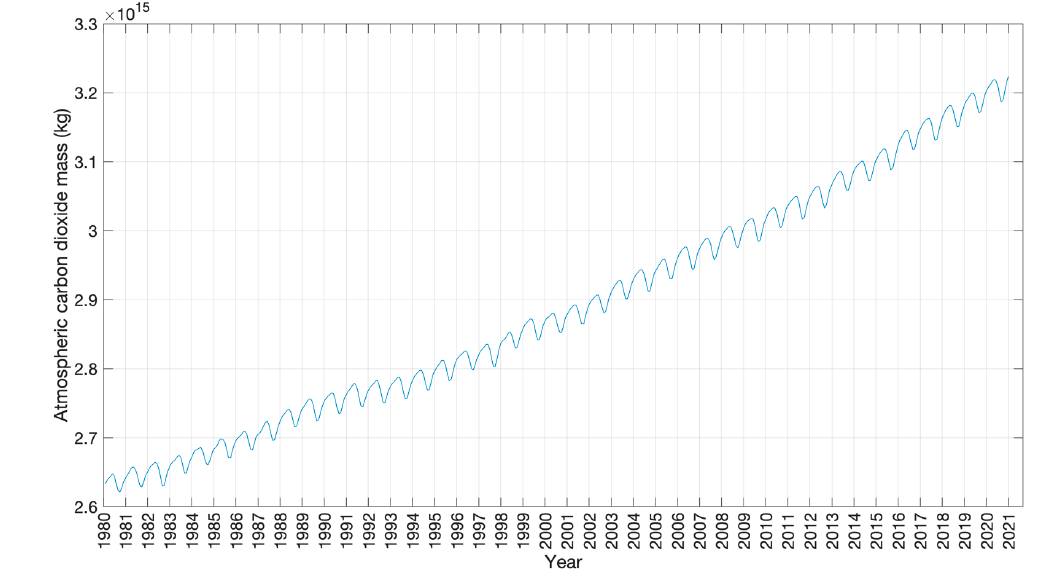
Figure A4. Global atmospheric carbon dioxide mass 1980–2021. Table A1. Stations data adapted with permission from Fraser et al. [8] for 1980. Copyright 1983 by the American Geophysical Union.flask is sampling and in-situ is the measurement performed in the